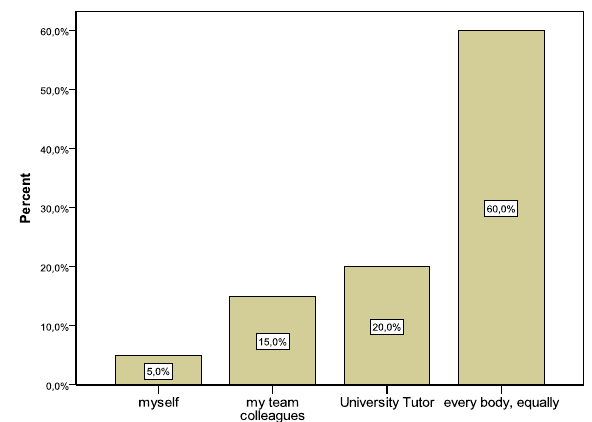
Figure 7. K-12 students’ answer to the question “Who do you think worked more in the robot?”